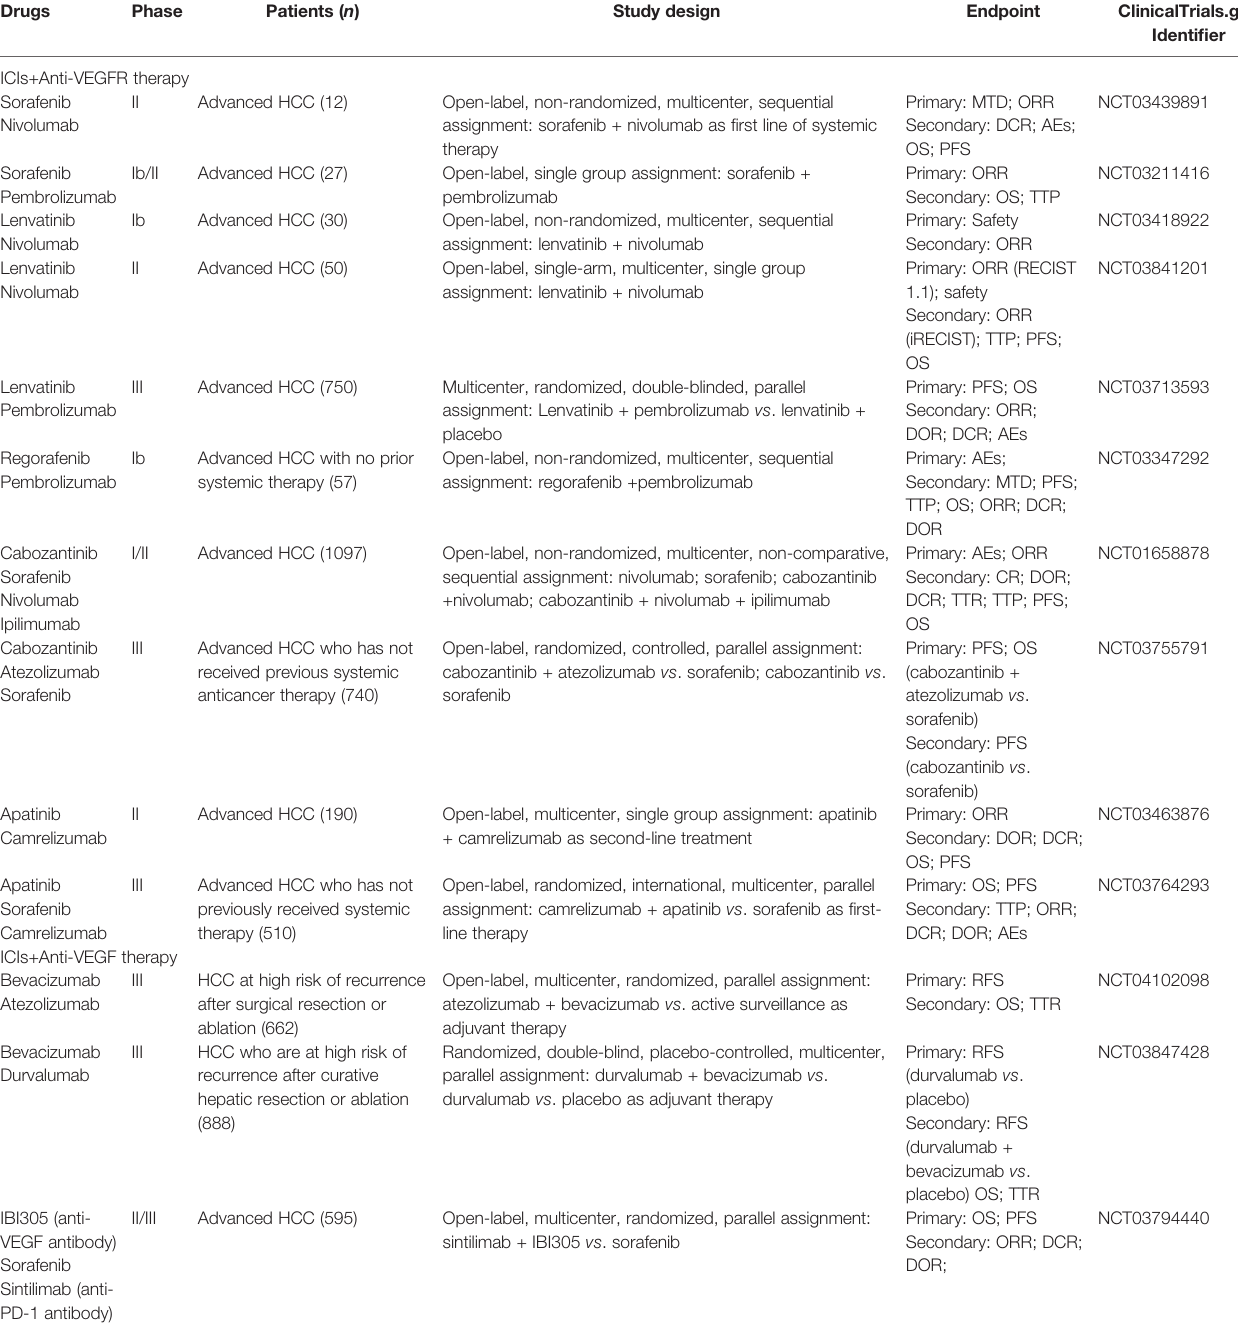
TABLE 3 | Ongoing studies incorporating ICIs and antiangiogenic agents in